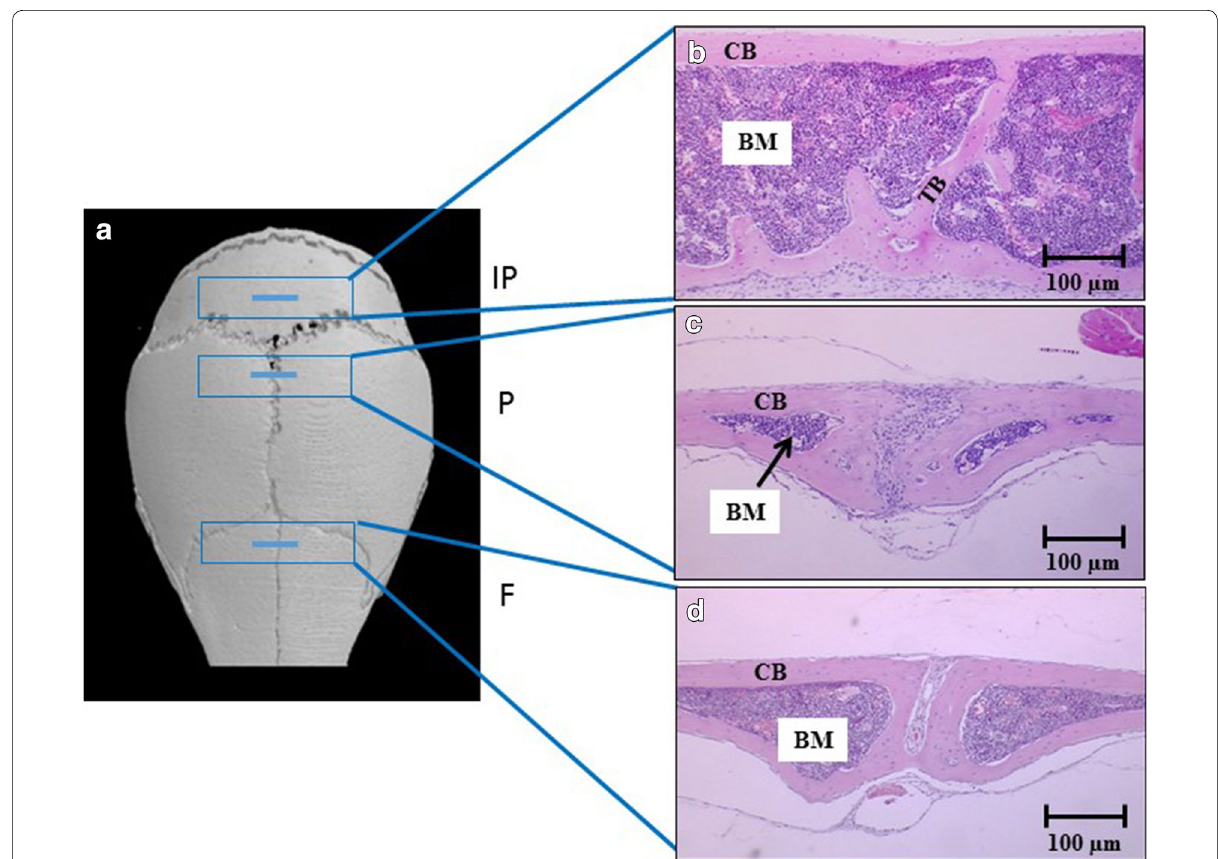
Fig. 1 Sectioning of calvarial bones across the regions of interest. a MicroCT model of a murine skull showing calvariae consisting of frontal (F), parietal (P) and interparietal (IP) bones. b – d Cross‑sections of frontal, parietal and interparietal bones, respectively. BM is bone marrow, CB is cortical